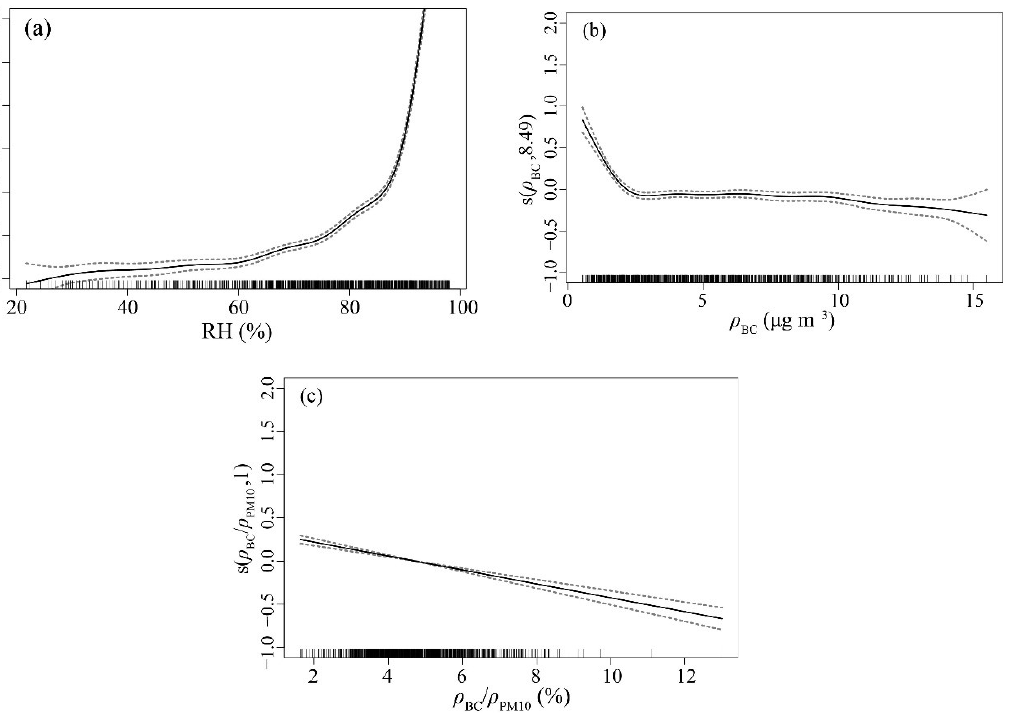
Figure 7. Effects of three explanatory variables on the variation of aerosol scattering hygroscopic growth factor. ( a – c ) represent the effect of RH, ρ BC and ρ BC / ρ PM10 , respectively.